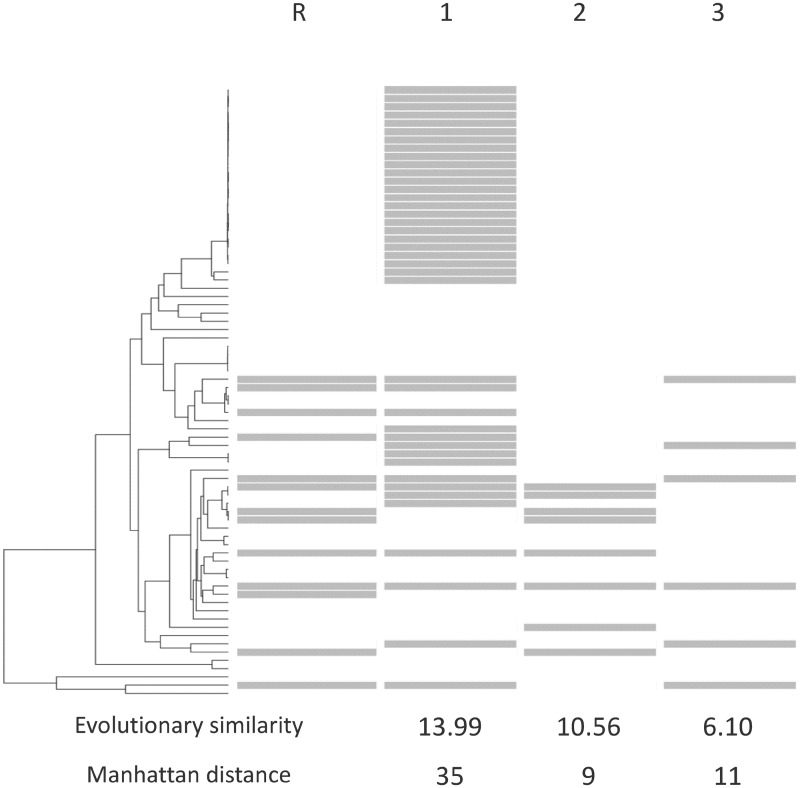
—Similarity of phylogenetic profiles (1, 2, 3) to a reference profile (R) according to Pagel’s likelihood-ratio statistics and Manhattan distance scores. Gray bars indicate the presence of a given gene in the genome that corresponds to the phylogenetic tree on the left. When considering the Manhattan distance, Gene 2 is the most similar to the reference profile, whereas Gene 1 has a very large Manhattan distance due to its representation in a closely related set of Clostridioides difficile genomes that do not contain genes in profile R. However, this drastic dissimilarity can be attributed to a single LGT event, and Gene 1 is most similar to the reference profile according to the likelihood-ratio statistic.